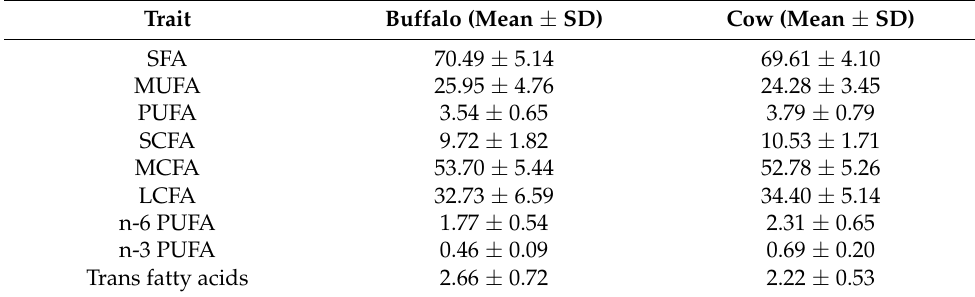
Table 3. Fatty acids’ profile of buffalo milk compared with cow milk.